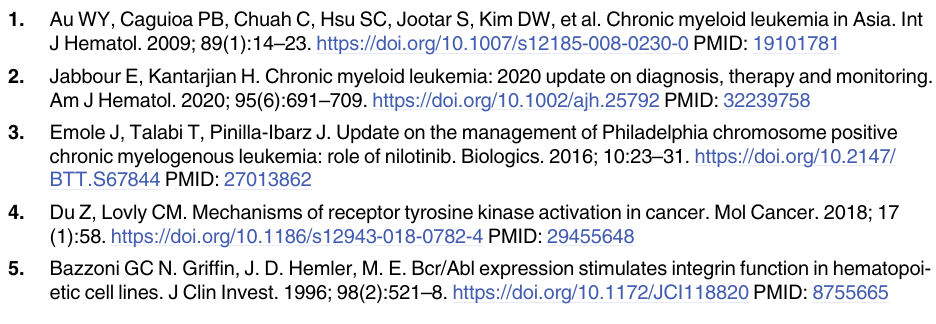
S1 Fig. TTD, PFS and OS curves used to inform the model. (TIF) S1 Table. Clinical inputs for scenario analyses.